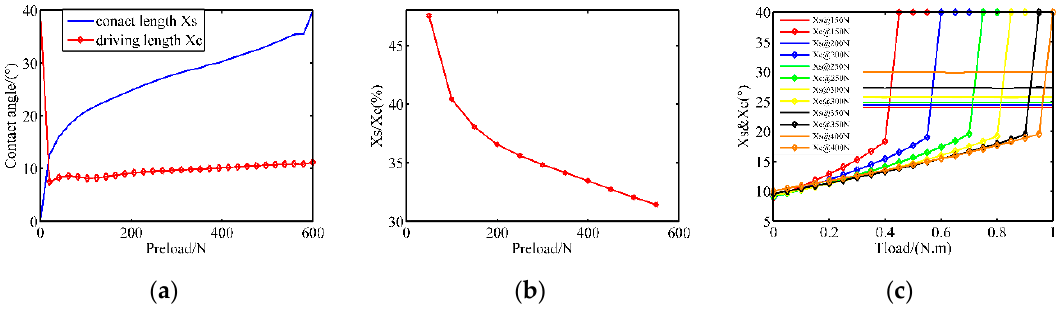
Figure 3. The contact parameters under diverse pre-pressures (simulation): ( a ) the contact angle and driving angel in no-load condition; ( b ) the proportion of driving zone in no-load condition; ( c ) the contact angle and driving angel with external load.